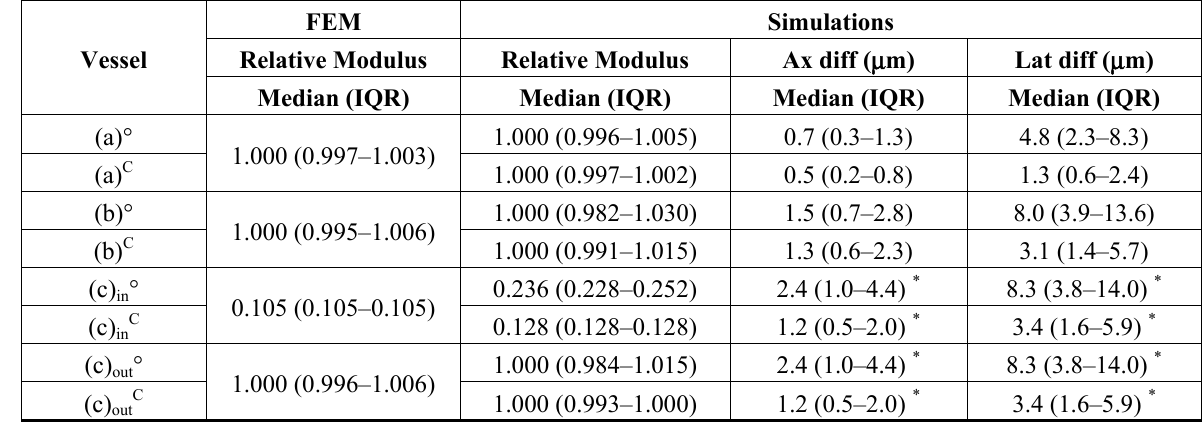
Table 1. Median and interquartile ranges (IQR) of the modulus reconstruction of the three vessels based on finite element modeling (FEM) and simulations. The median and IQR of the absolute differences between the input and output displacement fields are reported also. Vessel